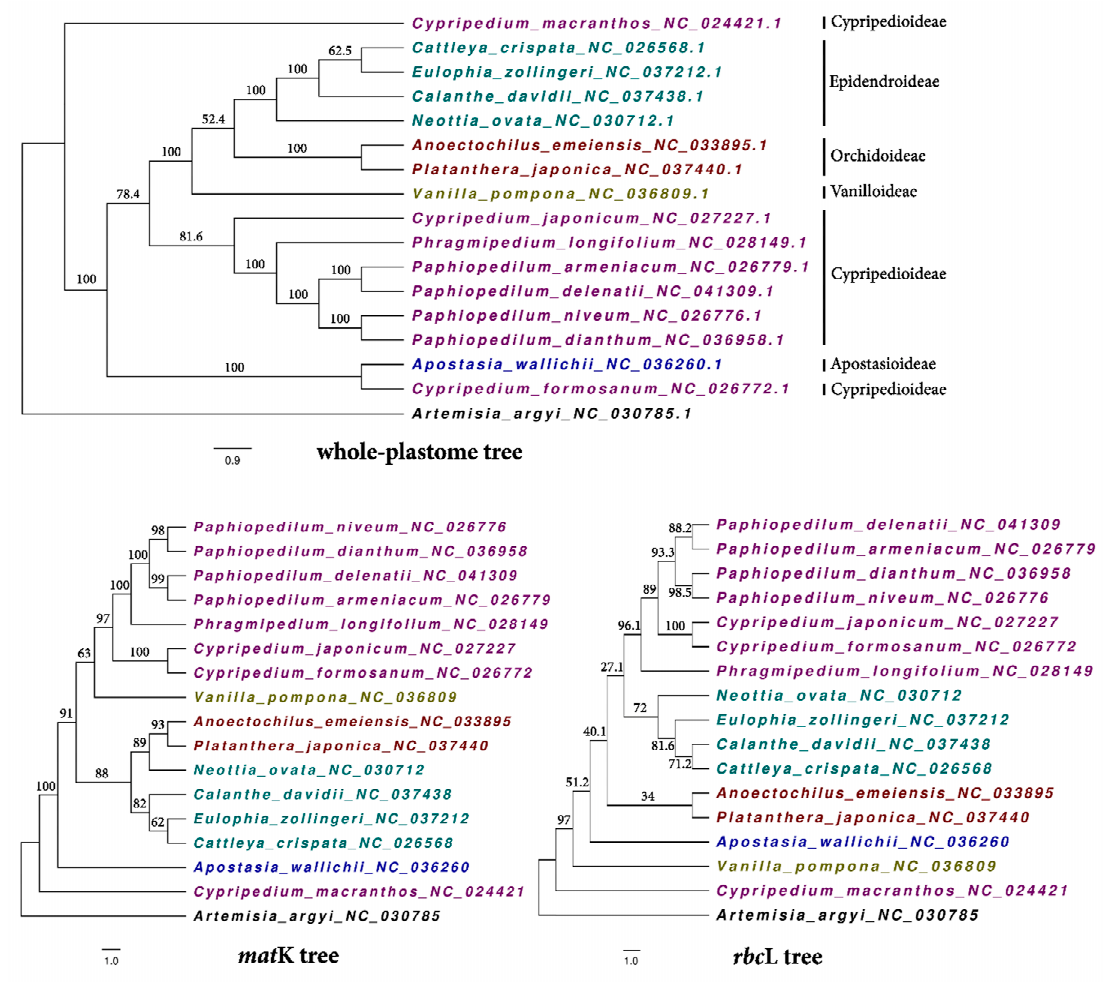
Figure 3. Cladogram of the phylogenetic relationship between P. delenatii and other Orchidaceae species based on maximum likelihood analysis. The number on the branches are bootstrap values.